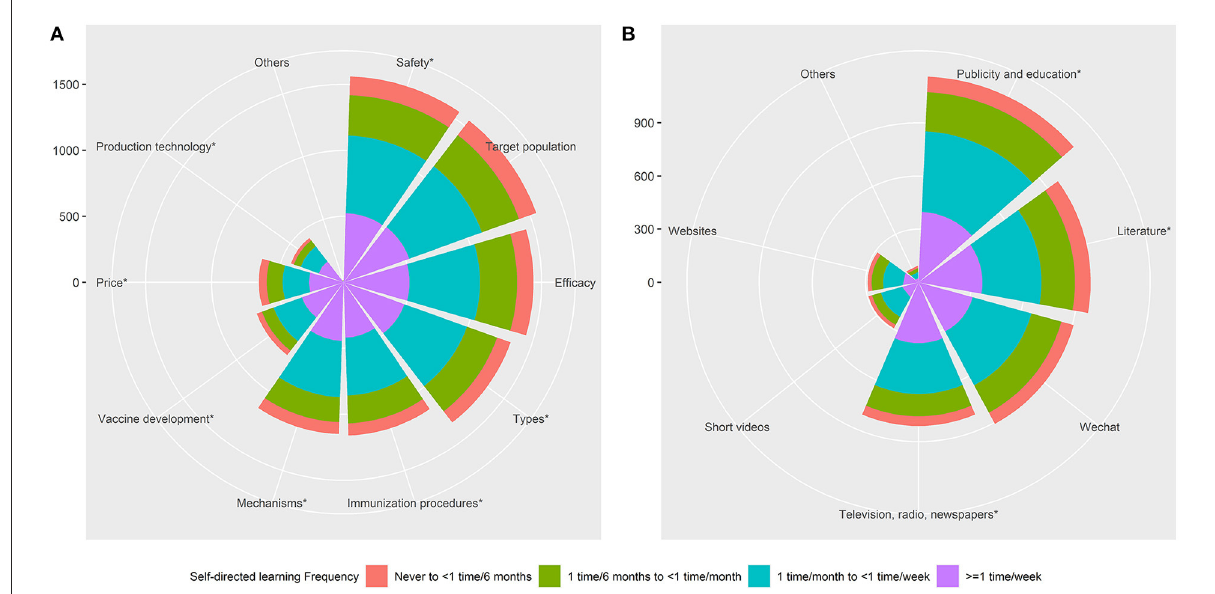
FIGURE1 Nightingale Rose Chart for learning topics and sources in participants with different SDL frequencies. (A) Learning topics. (B) Learning sources. Note: The *symbol indicates that there is a significant difference among people with different SDL frequencies on this item.